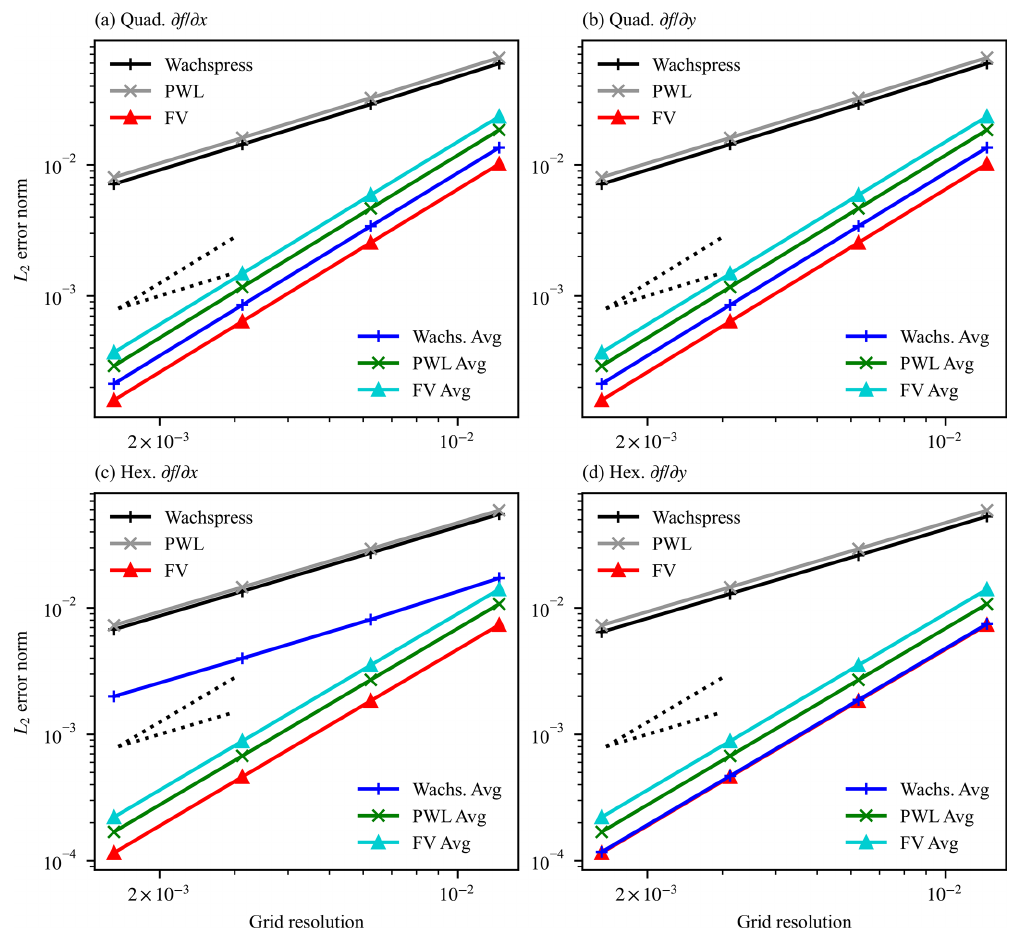
Figure 5. Scaling of L 2 error norm against grid resolution for the model calculation of the gradient of an analytical function in the (a, c) x and (b, d) y directions for a planar test case with a regular (a, b) square cell and (c, d) hexagonal cell mesh. Grid resolution is the mean distance between cell centers. Ideal first- and second-order scaling gradients are also shown as dotted